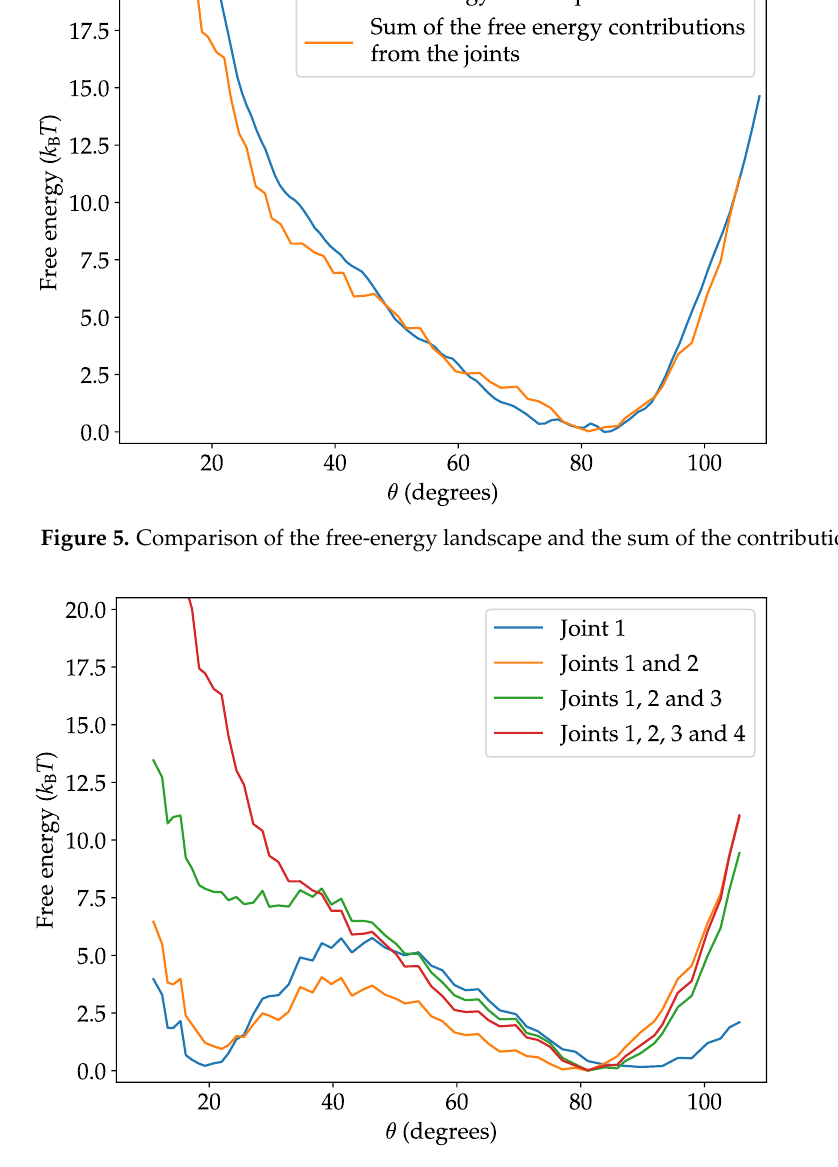
Figure 6. The Free-energy contributions of each joint to the overall free-energy